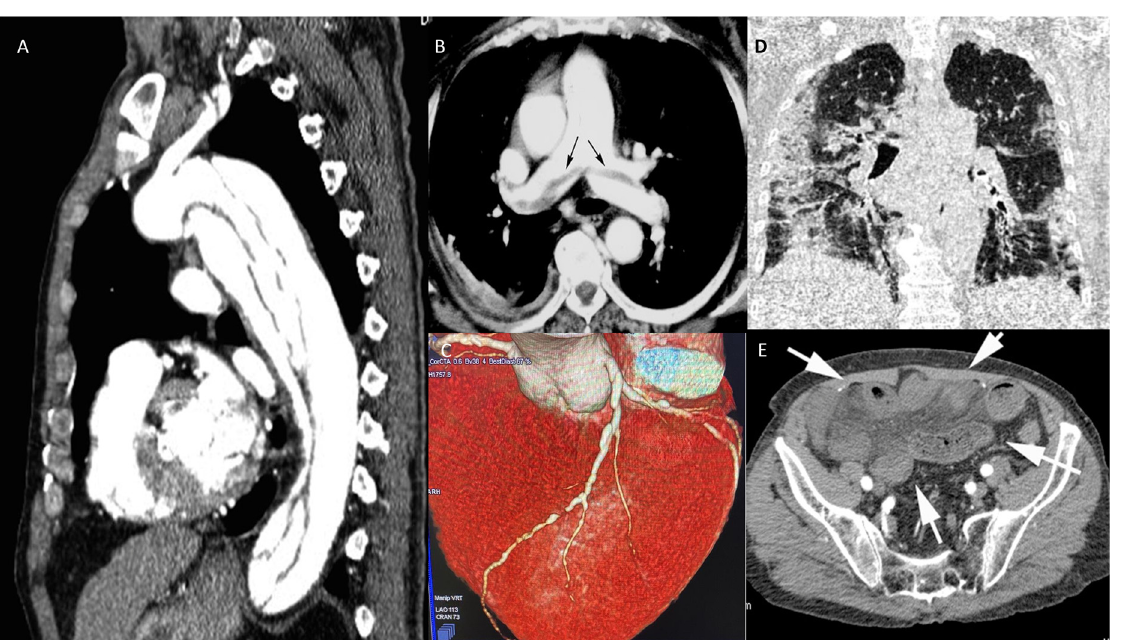
Figure 4. Use of CT in acute heart failure.